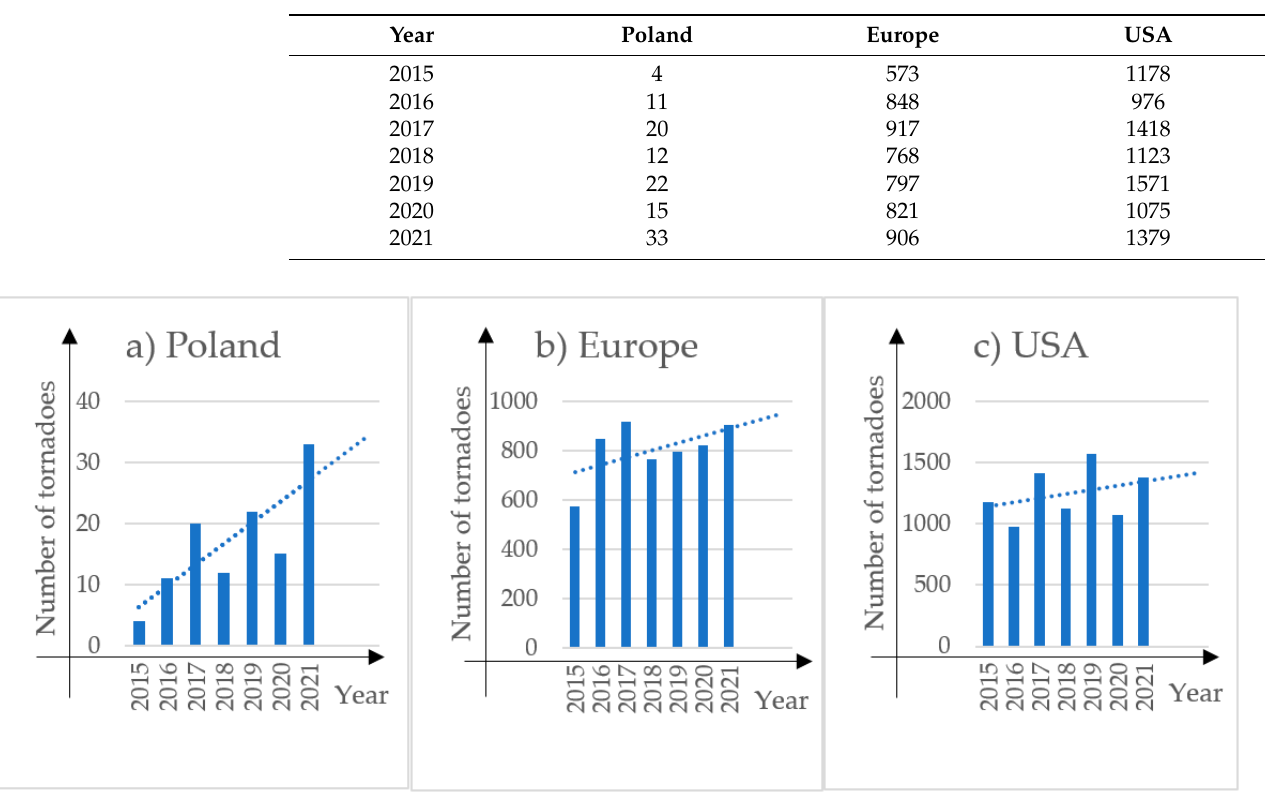
Figure 3. Bar graphs of the recorded number of tornadoes over the years 2015–2021. ( a ) in Poland, ( b ) in other areas of Europe, ( c ) in the USA [21,22].